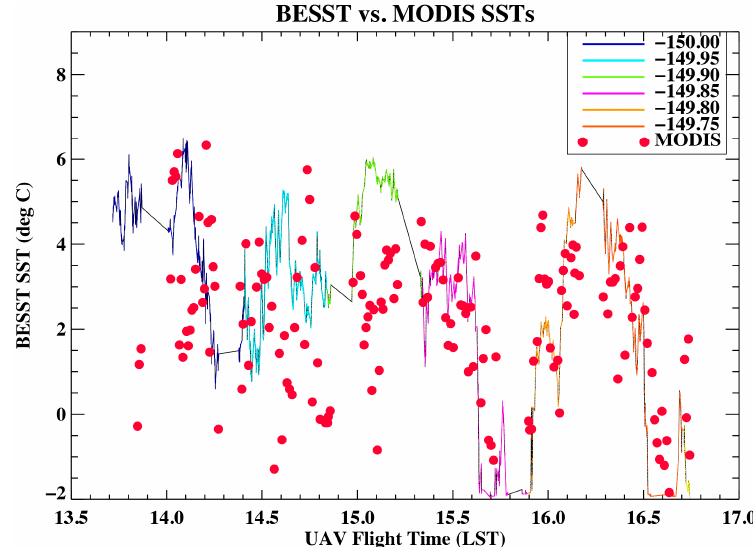
Figure 3. BESST SST time series, shifted back in time by 50 min, with superimposed MODIS SST matchups (red dots) from the maximum value composite.